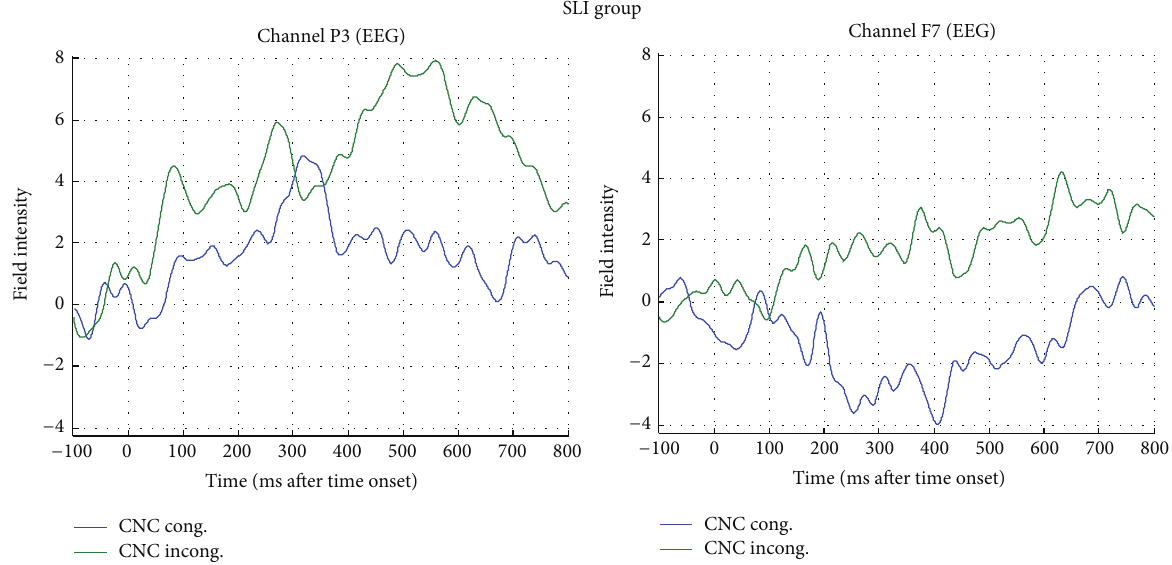
Figure 9: ERP recordings corresponding to concrete-congruent and concrete-incongruent stimuli in the SLI group, in left parietal (P3) and frontal (F7)